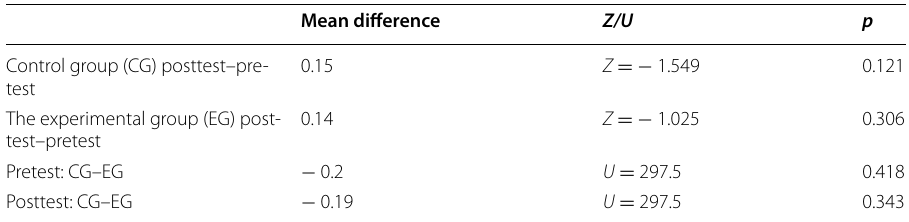
Table 10 Comparisons of the cohesion and coherence